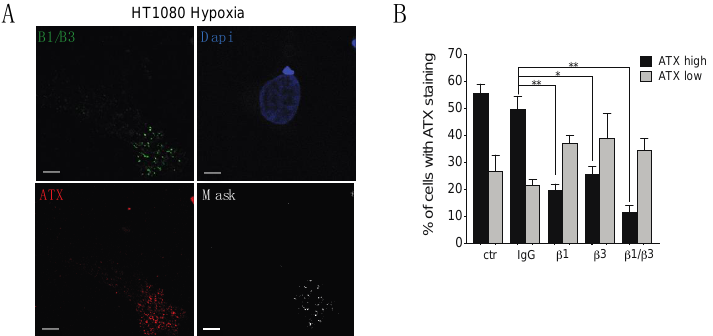
Figure 8. Evaluation of integrin contribution to the subcellular localization of ATX in hypoxic cancer cells. ( A ) Representative immunofluorescence images of HT1080 cells cultured on non-fluorescent gelatin for 4 h in hypoxia (1% O 2 ) are shown. Cells were stained for ATX (red) and β 1 and β 3 integrins (green). Nuclei were stained with DAPI (blue). Mask overlay shows co-localization of ATX and integrins (white). Magnification 60 × , scale bars, 5 µ m. ( B ) HT1080 cells were plated on non-fluorescent gelatin and incubated with control (ctr) IgG, β 1, β 3 or β 1 and β 3 integrin blocking antibodies for 30 min followed by 3 h incubation under hypoxia (1% O 2 ). Cells were then stained for ATX (green) and nuclei were stained with DAPI (blue). The percentage of cells with ATX staining (high / low) is shown. N = 3. Bars represent the mean ± SEM (* p < 0.05, ** p <